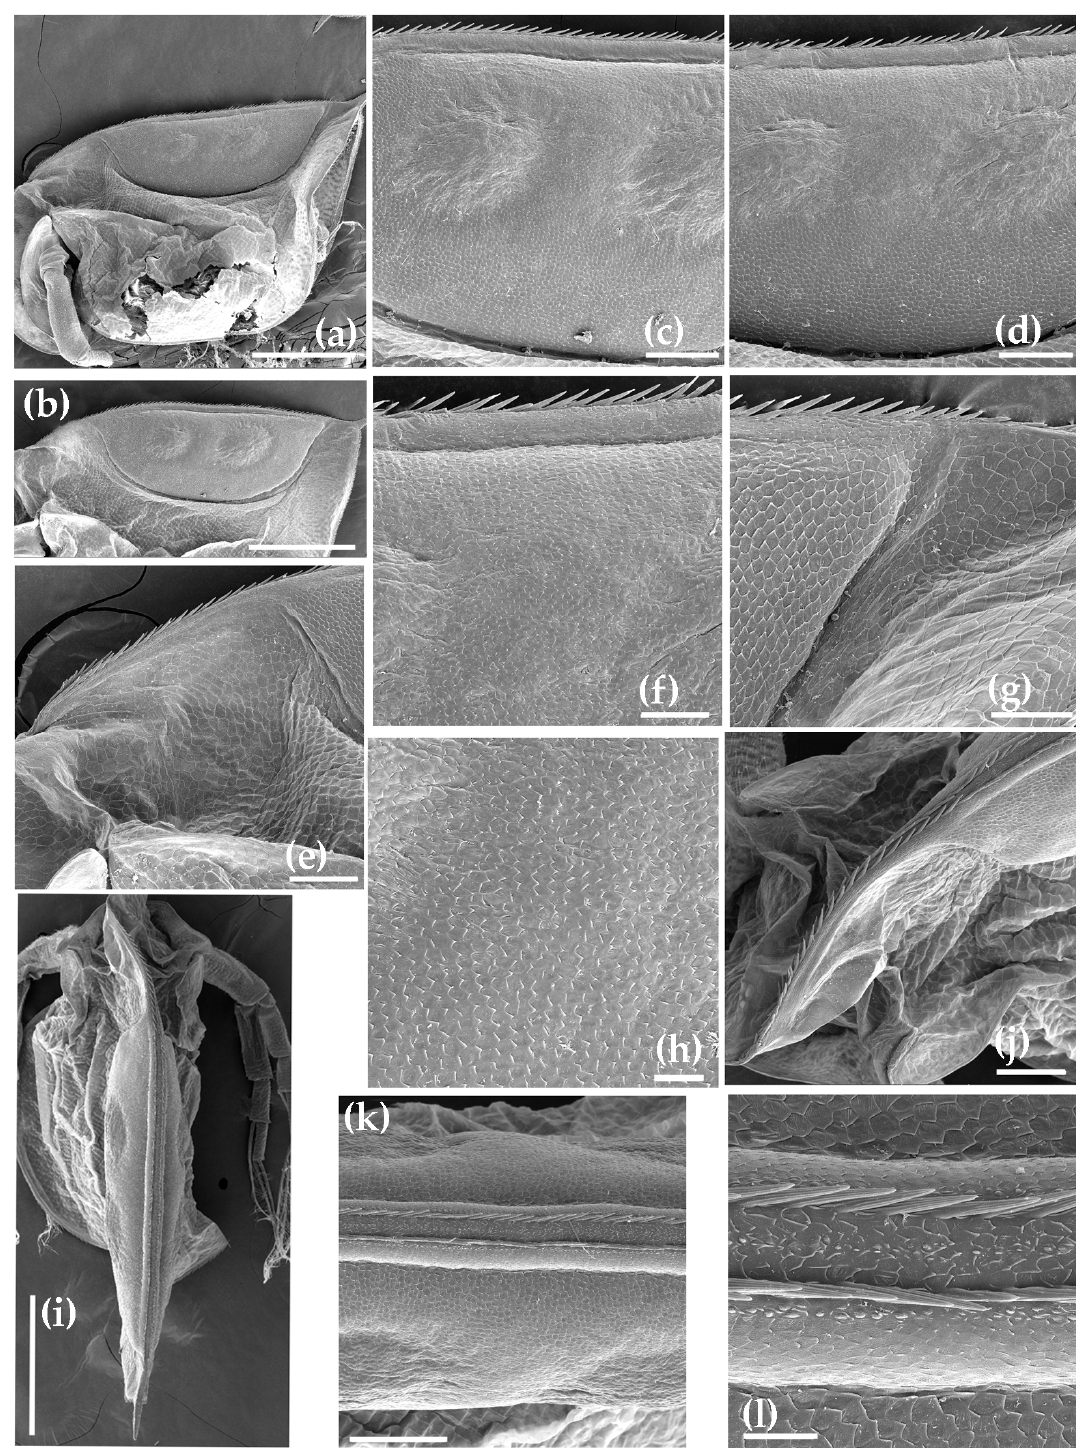
Figure 7. Daphnia arabica sp. nov., ephippial females from Al Shuwaib Dam, near Al Ain city, United Arab Emirates. ( a , b ) Ephippium, lateral view. ( c , d ) Central portion of ephippium with resting eggs. ( e ) Anterior portion of ephippium, lateral view. ( f ) Central portion of ephippium dorsal margin. ( g ) Posterior portion of ephippium. ( h ) Central portion of ephippium on higher magnification. ( i ) Ephippium, dorsal view. ( j ) Anterior portion of ephippium, dorsal view. ( k , l ) Ephippium dorsal margin on different magnifications. Scale bars are 0.5 mm for ( a , b ); 0.1 mm for ( c – e ), ( j , k ); 0.05 mm for ( f , g ); 0.02 mm for ( h , l ).